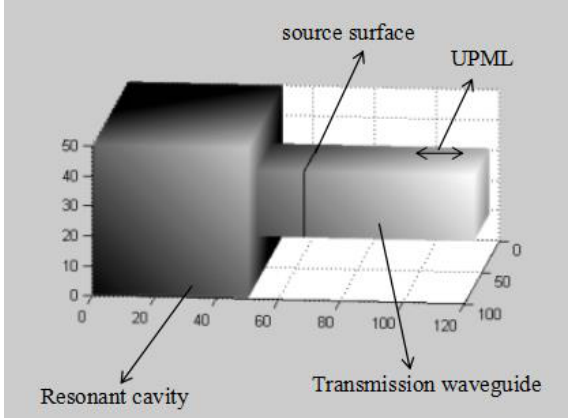
Figure 3: Structure model of waveguide loaded resonator